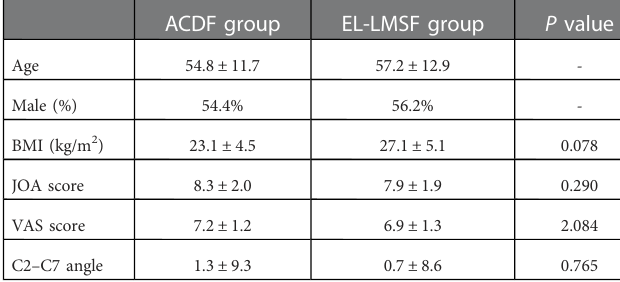
TABLE 1 Clinical characteristics of the patients before